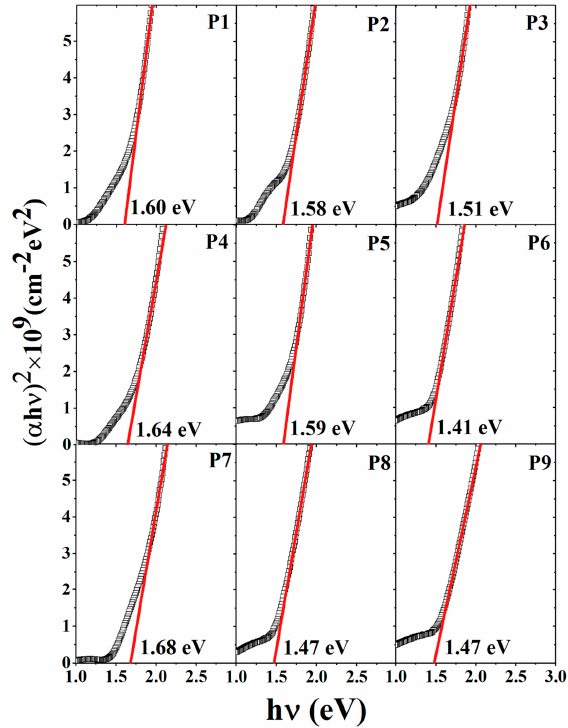
Figure 5. Tauc analysis and bandgap determination for the sulfurization annealed Cu 2 S–SnS 2 –ZnS 2 thin films.